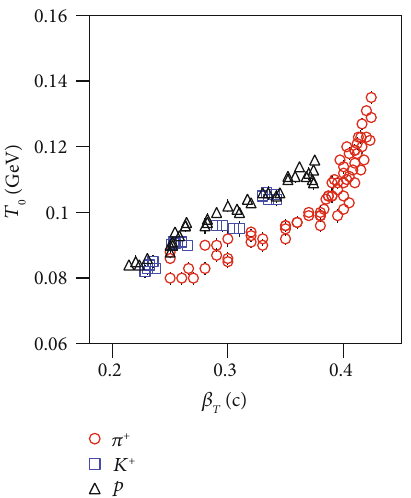
β 0 and T from the blast-wave model.